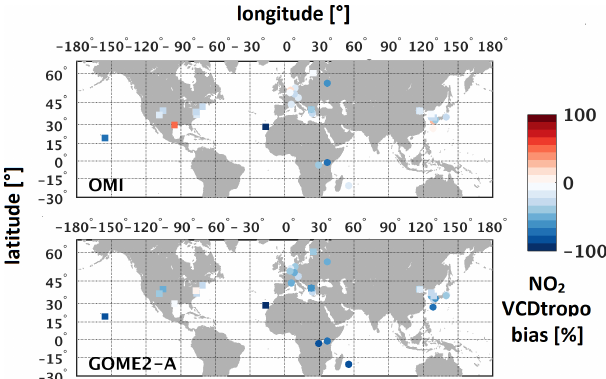
Figure 6. Daily median relative bias at each station for OMI DOMINO v2 and GOME-2A GDP tropospheric NO 2 columns. MAX-DOAS stations are represented with circles and direct sun stations with